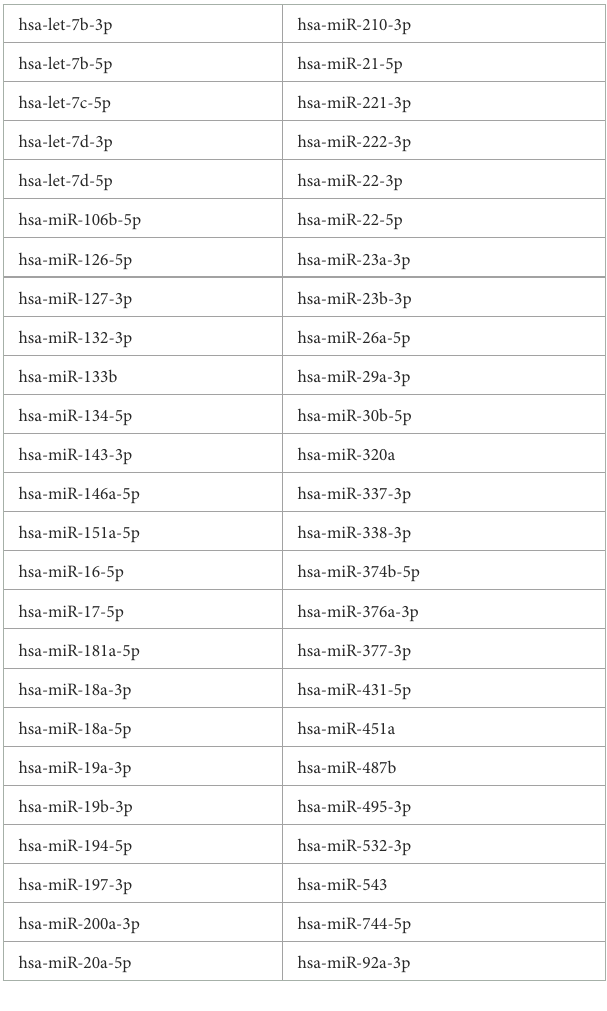
TABLE 1 List of miRNAs subjected to statistical